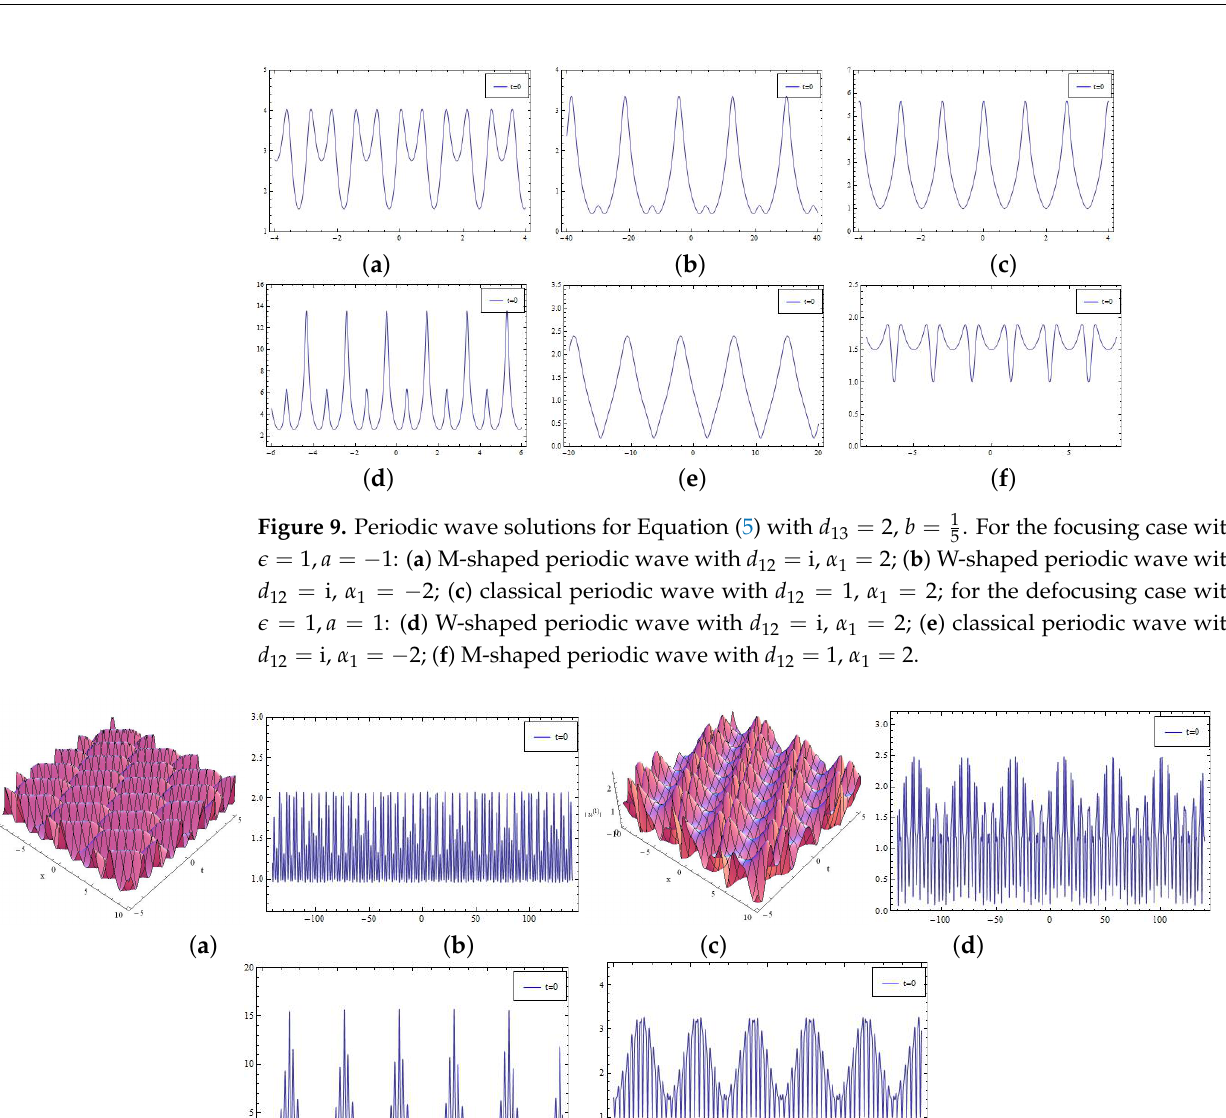
. For the focusing case 5 , d 13 = 2; 2 ; for the defocusing case 2 ; ( f ) breather-periodic 2